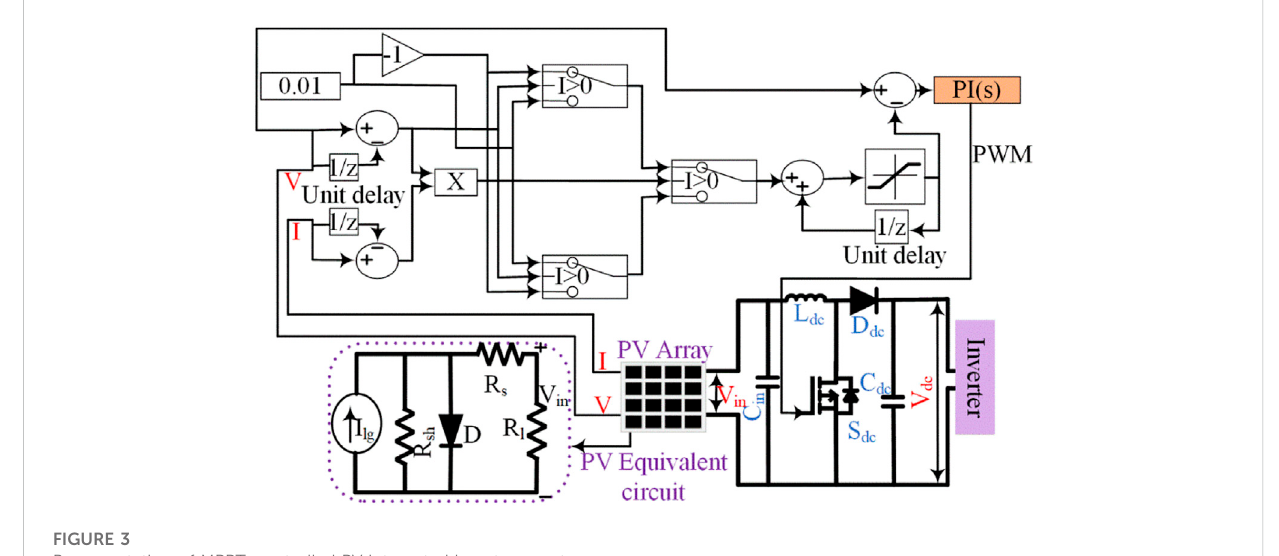
FIGURE 3 Representation of MPPT-controlled PV integrated boost